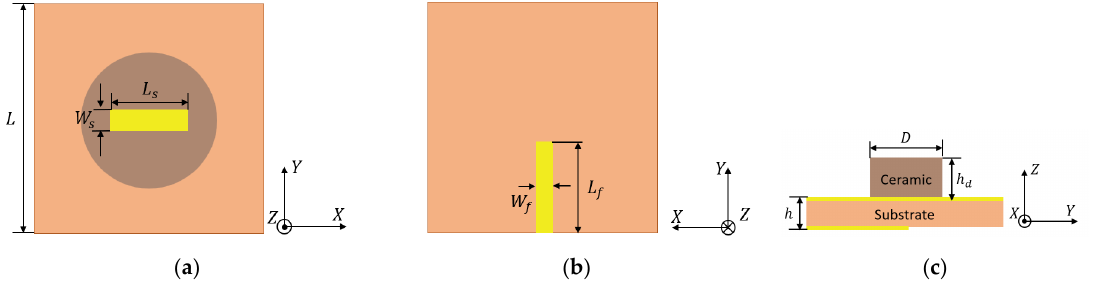
Figure 1. Configuration of the proposed DRA: ( a ) top view; ( b ) back view; ( c ) side view. L = 60 mm; h = 0.8 mm; D = 30.2 mm; h d = 15 mm; W f = 2.18 mm; W S = 3.5 mm; L f = 4 mm; Ls = 20 mm.